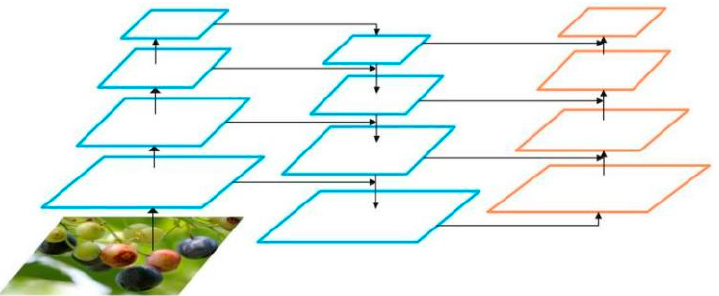
Figure 6. Structure diagram of FPN + PAN(The arrows indicate the direction of forward